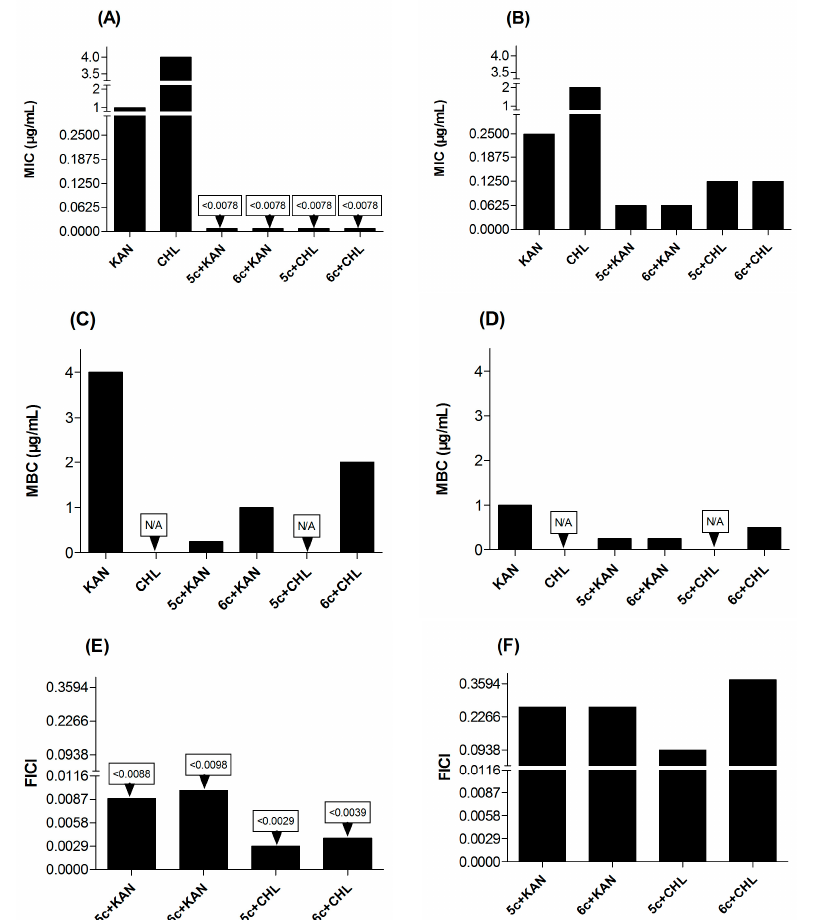
Figure 4. Synergistic effect of different antibiotics with compounds 5c and 6c against MRSA USA300 and B. subtilis 168. ( A ) MIC of different compounds against MRSA USA300 and ( B ) B. subtilis 168; ( C ) MBC of different compounds against MRSA USA300 and ( D ) B. subtilis 168; ( E ) FICI of different compounds against MRSA USA300 and (F ) B. subtilis 168.